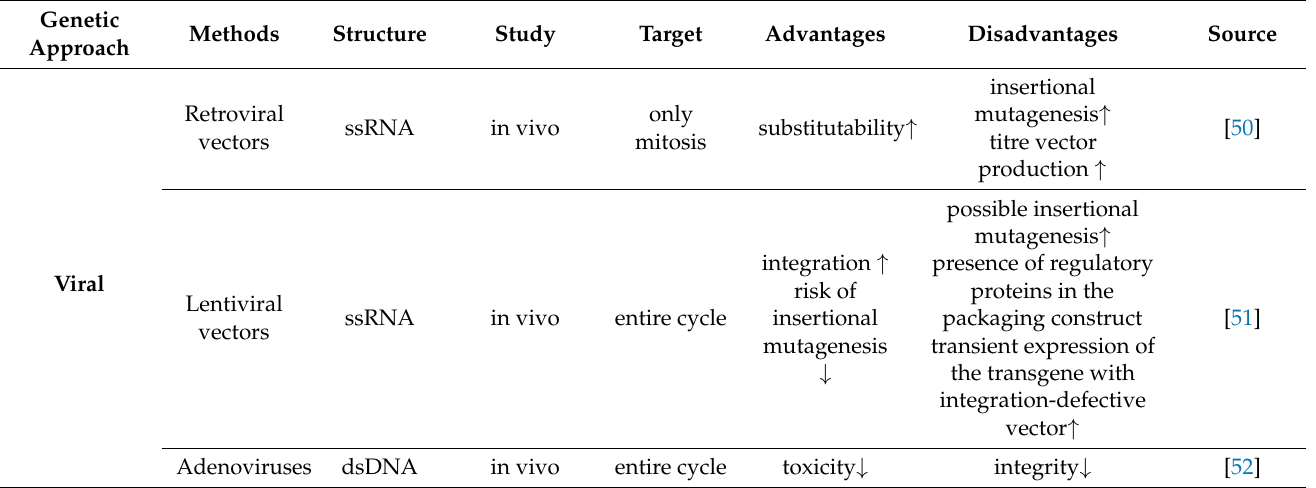
Table 1. The characteristic of different engineering methods of